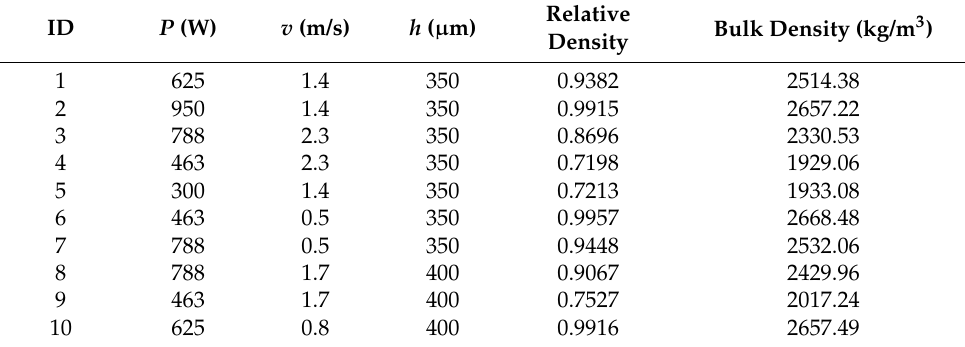
Table A3. Manufacturing parameters and experimental data adapted from [17]. Complementing relevant information and assumptions are the following; material: AlSi10Mg, theoretical